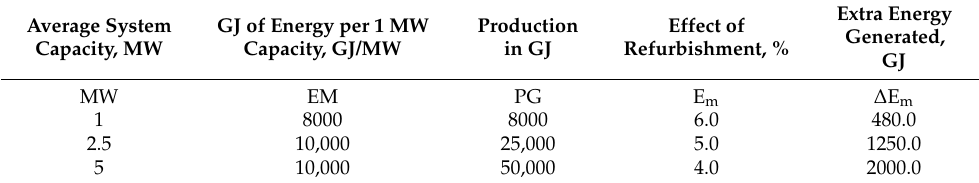
Table 5. Extra energy generated with refurbishment for system capacities from 1 MW to 5 MW.